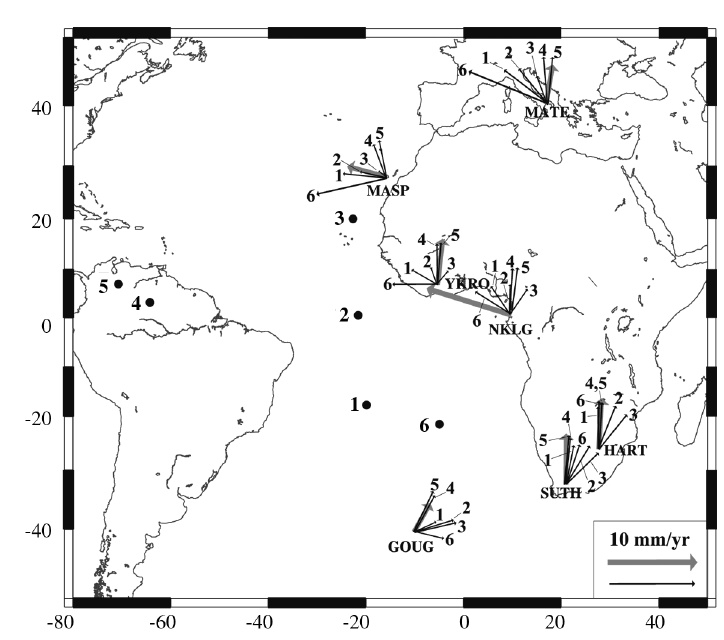
Fig. 5. Nubia-Eurasia Euler poles derived from geodetic data (black dots numbered from 1 to 6) and respective velocities (thin arrows with numbers) predicted by such poles at the African GPS sites reported in table IIIa. Thick grey arrows show the residual ITRF2000 velocities (table IIIa) with respect to the Eurasia absolute pole provided by Prawirodirdjo and Bock (2004). Poles 1 to 3 are taken from literature, while the poles 4 to 6 are computed in this work taking into account slightly different data sets with respect to the first 3 poles (see table